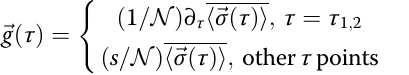
theory 30 states that the quench dynamics exhibit non- trivial topology captured by the time-averaged spin tex- ture in momentum space. Unlike the previous theory, here we de fi ne the averaged spin polarization σ z ð T ; τ Þh i (cid:10) and σ y ð T ; τ Þ